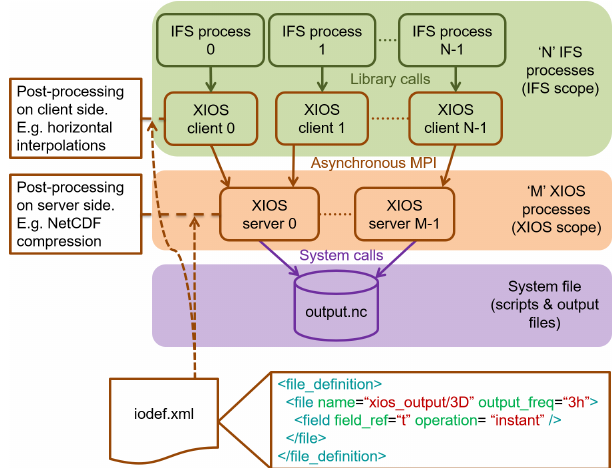
Figure 3. Scheme of the IFS CY43R3 and XIOS 2.0 integration. It overviews how the different parts are